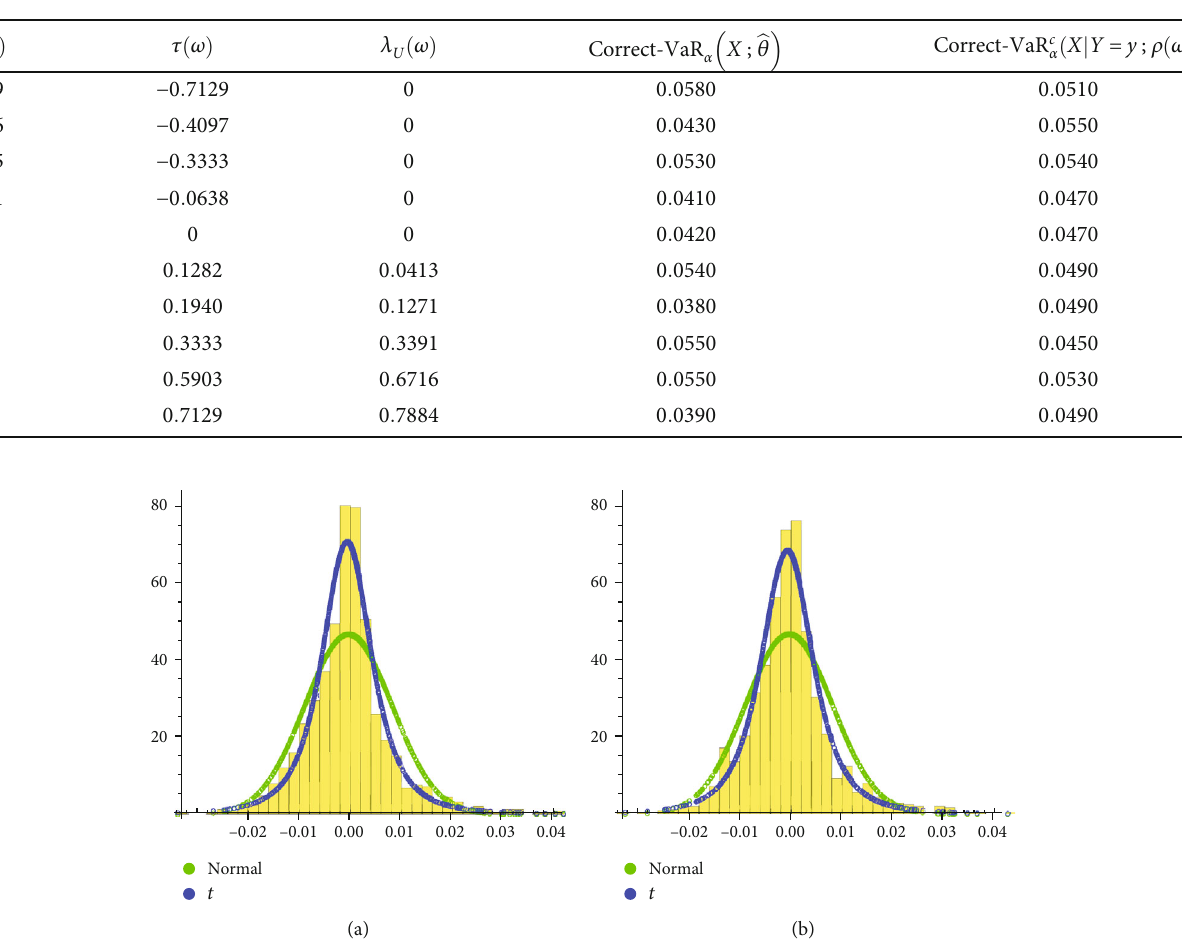
Table 6: The accuracy of estimative VaR forecasts via Correct-VaR; its value corresponds to α as this refers to the number of violations, i.e., the number of observations above the estimative VaR forecast.